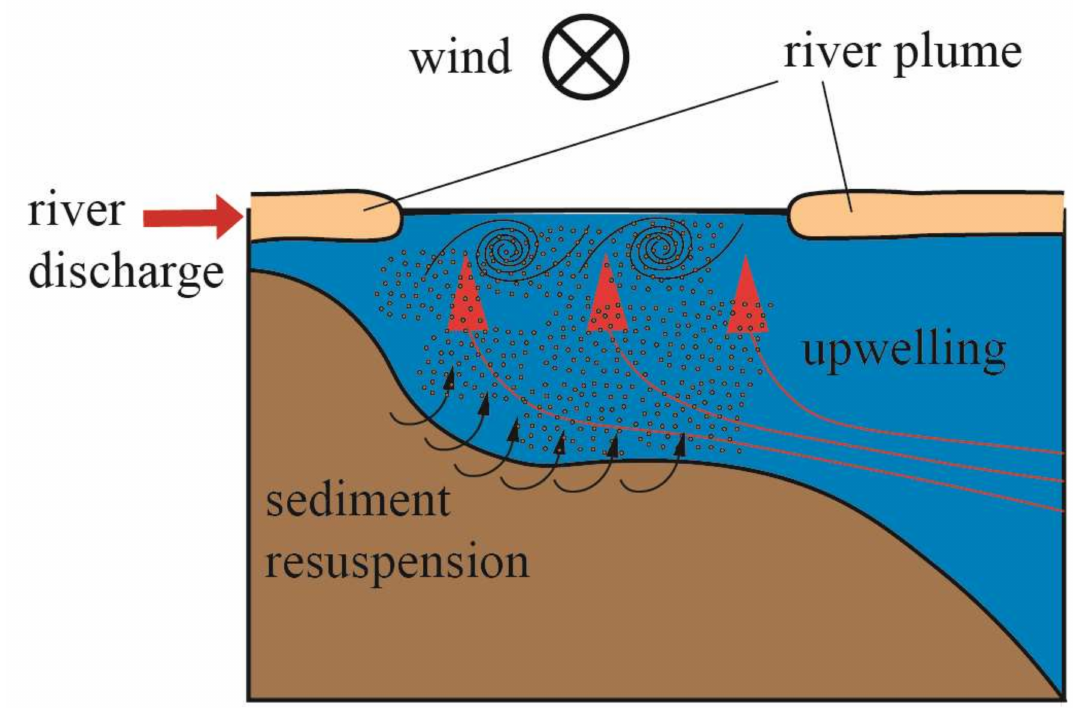
Figure 11. Schematic of formation of a saline, cold, and turbid “hole” within a plume as a result of advection and mixing of a river plume during wind-induced upwelling